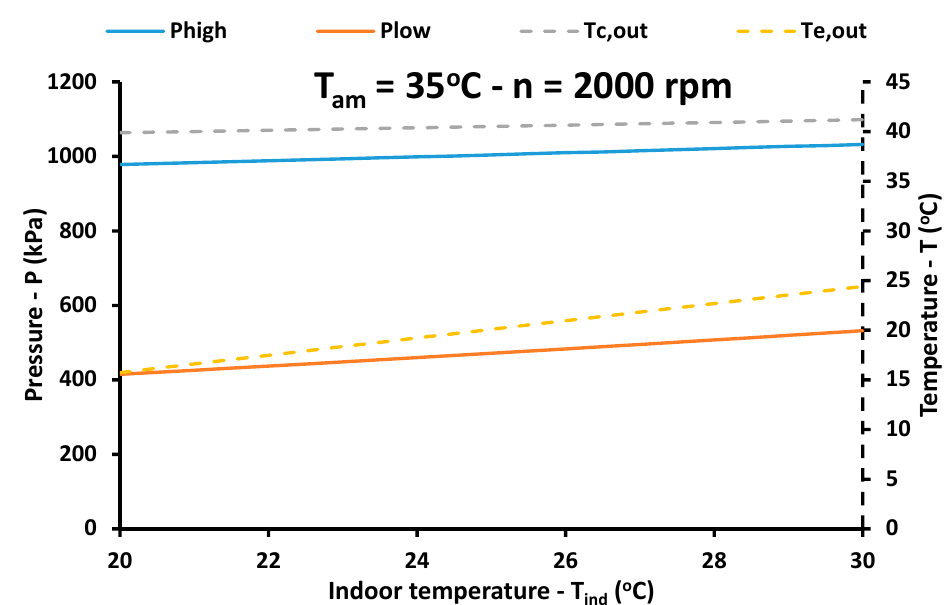
Figure 12. Compressor pressure ratio for different indoor temperatures.